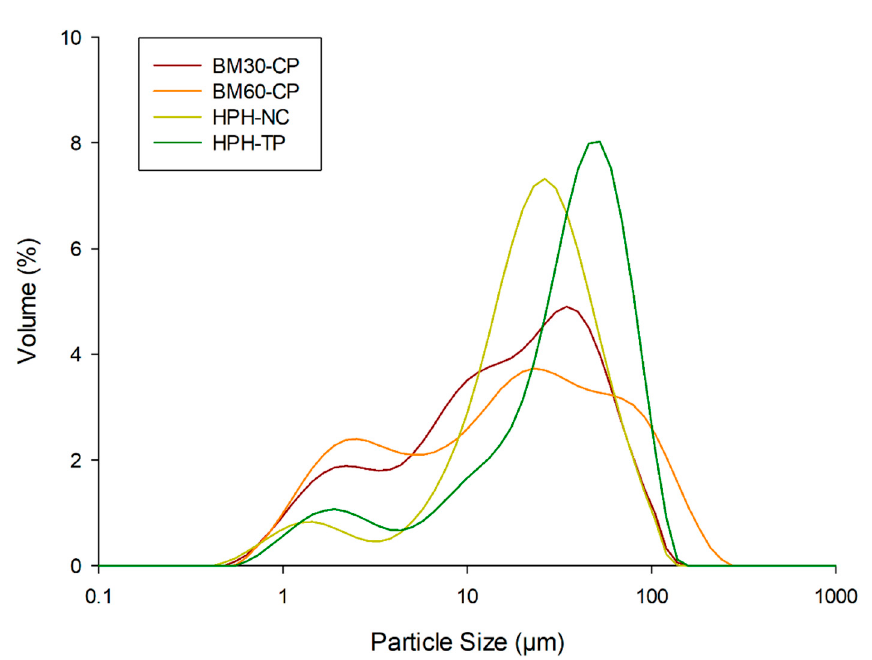
Figure 5. Particle size distribution of Pickering emulsion stabilized with (red line) BM30-CP, (orange line) BM60-CP, (light green line) HPH-NC, and (dark green line) HPH-TP. Table 2. Particle size distribution (expressed as span and characteristic diameters) of emulsions stabilized with BM30-CP, BM60-CP, HPH-NC, and HPH-TP. Pickering Stabilizer